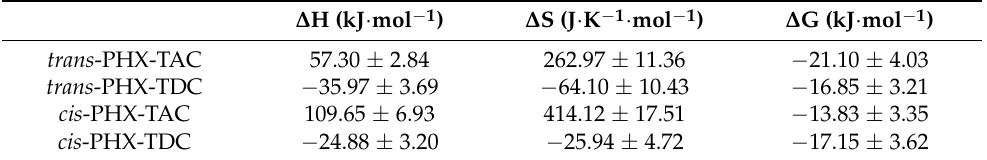
Table 2. Thermodynamic parameters of the complex formation between the cavitands and the isomers of PHX. ∆ G values have been determined for 298 K.